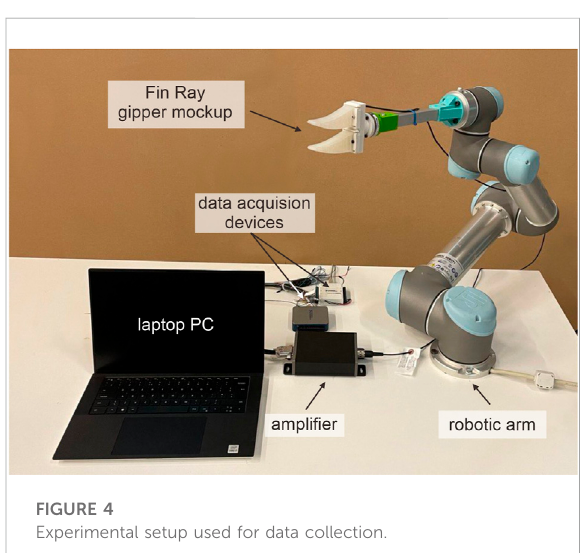
FIGURE 4 Experimental setup used for data